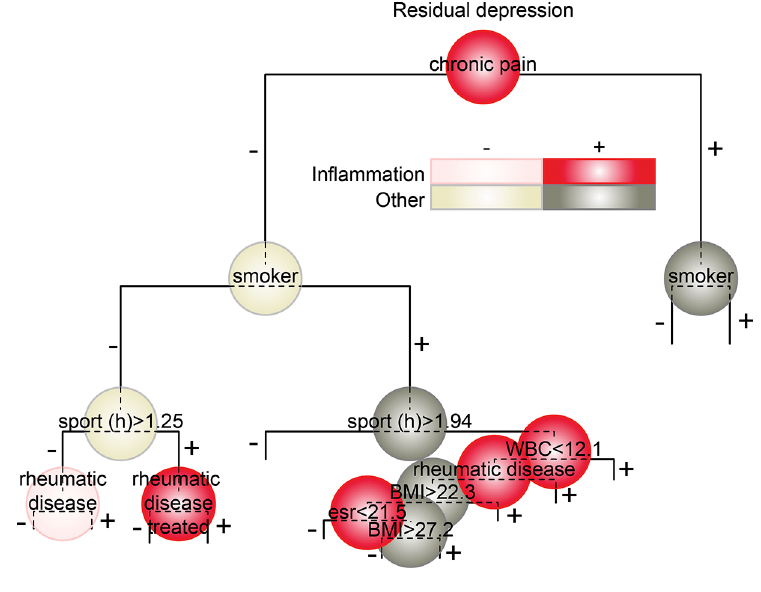
figure 1. Hierarchical plot of predictors of residual depression. Circles are color-coded by the calculated effect on residual depression (increase or decrease; scale). Of 20 physi- ological, psychological and medical parameters entered into the model, chronic pain, smoking, sport activity, inflammation parameters, and BMI all emerged as significant predictors. Note that chronic pain increases the residual depression (top row), whereas in pain-free volunteers, smoking increases the residual depression (second row), and over 1.94 exercise hours per week (third row, middle panel) elevated depression